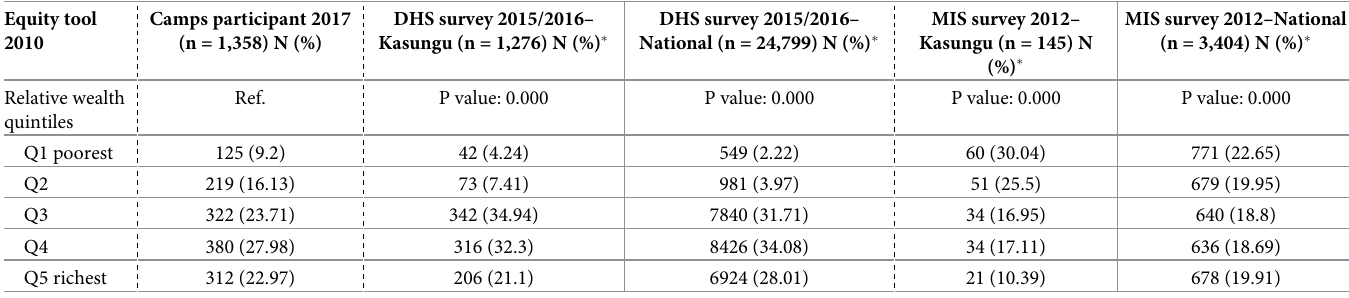
MIS survey 2012–National (n = 3,404) N (%) �